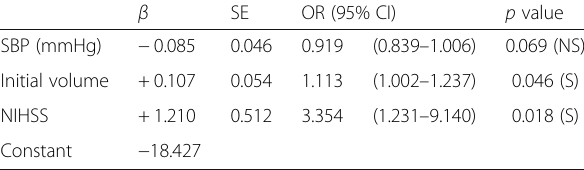
Proportional by chance accuracy criteria=89.7%. The model predicts overall accuracy rate=99%. Null model − 2 log likelihood=91.177; full model − 2 log likelihood=12.247. Overall model chi-square =78.930, d.f=4, p <0.001 (HS) Hosmer and Lemeshow goodness of fit test p =1.000 (NS), β regression coefficient, SE standard error, OR odds ratio, 95%CI 95% confidence interval. p <0.05 is